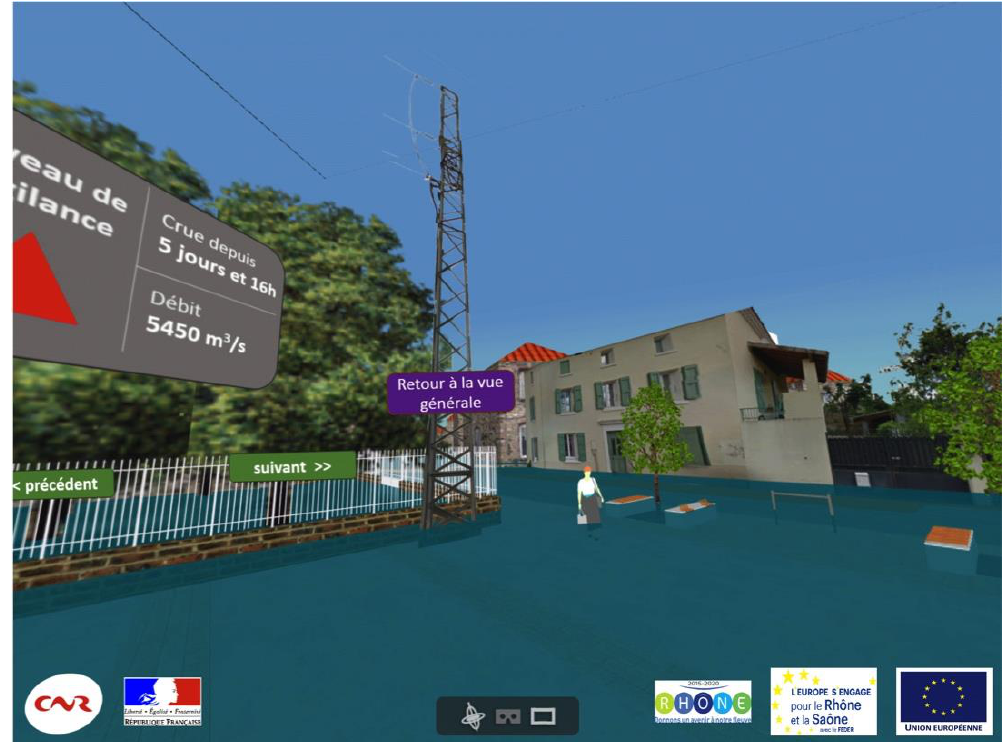
Figure 5. Example of the 360° images produced for immersive visualization (with a smartphone inserted into a virtual reality (VR) headset). Purple and green panels can be used to navigate between different moments in time (during the simulated flood). Grey panel gives information about water flows (m 3 per second), point in time (number of days since the beginning of the flood), and the corresponding level of vigilance (here red).